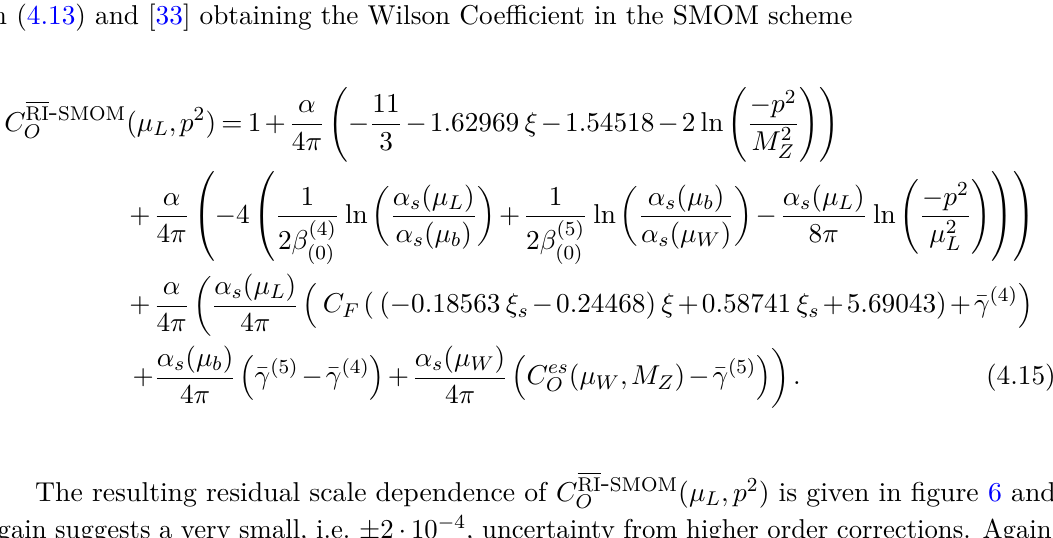
Figure 6. Residual scale dependence of the low-scale Wilson coefficient C RI = 0 (dark green curve). As in figure 5, the residual scale dependence ξ = ξ s = 0 , − p 2 = 9 and γ (2) W is suppressed by α . The light green shaded area shows the effect of the value of γ (2) contribution: the top limit is obtained with γ (2) = − 100 , while the bottom limit is given by γ (2) W